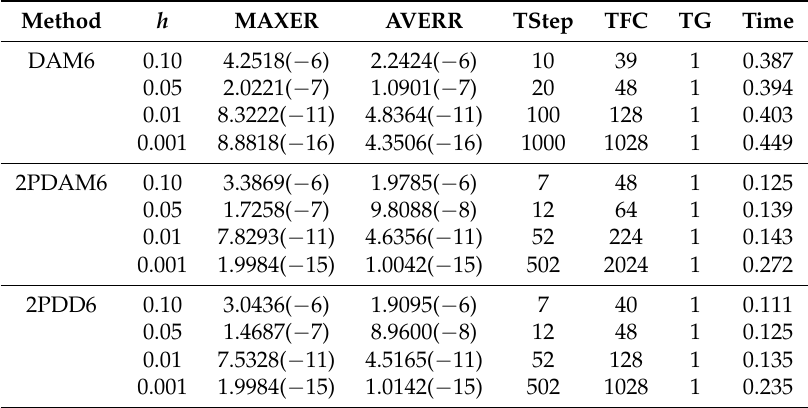
Table 3. Results for solving Test Problem 3.